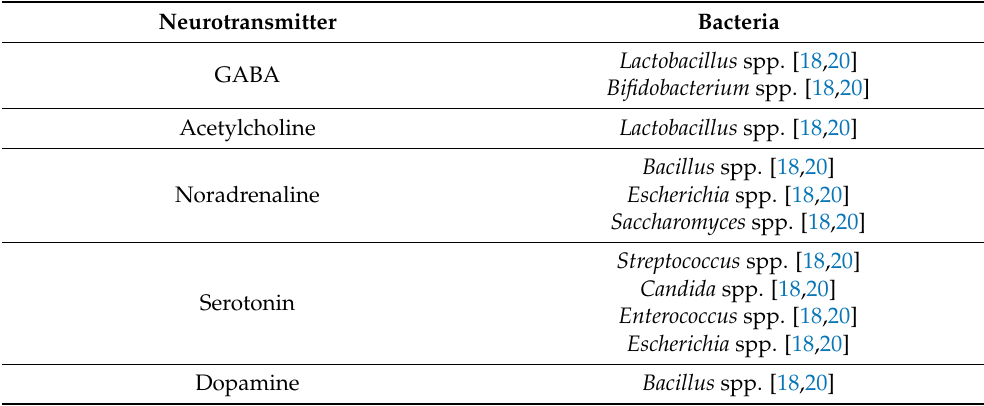
Table 1. A non-exhaustive list of major brain neurotransmitters and bacterial strains producing these